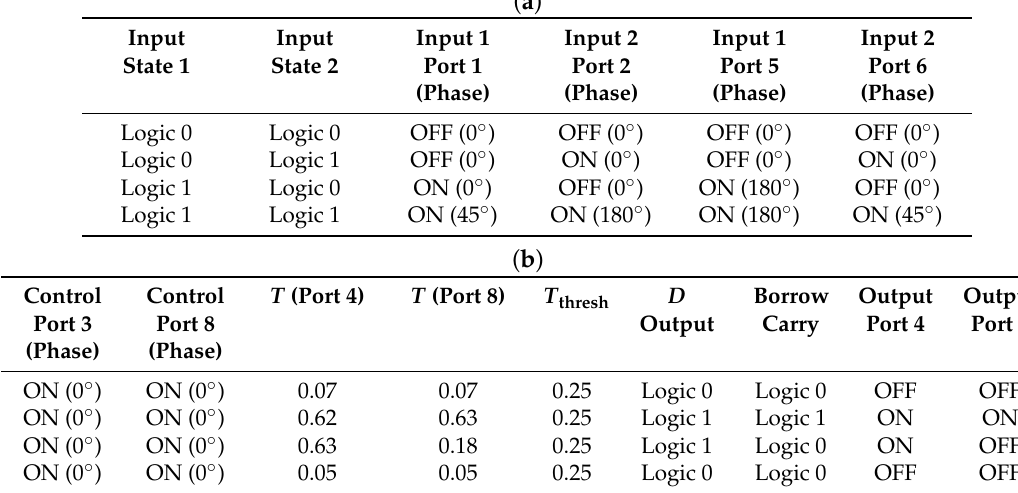
Table 2. Operation of the transmission for the proposed plasmonic